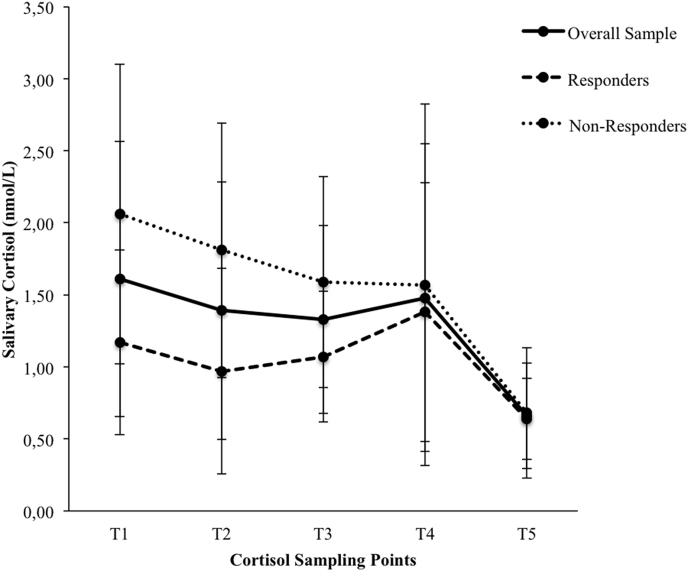
Salivary cortisol levels at the five sampling points for overall sample, responders and non-responders. Error bars represent standard deviations. nmol/L = nanomoles per liter.